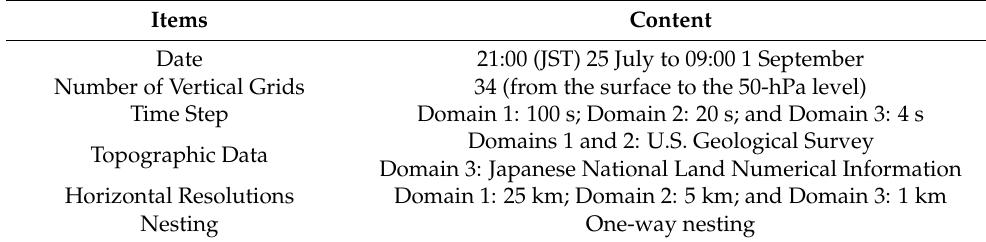
Table 2. Calculation conditions for the WRF simulations.